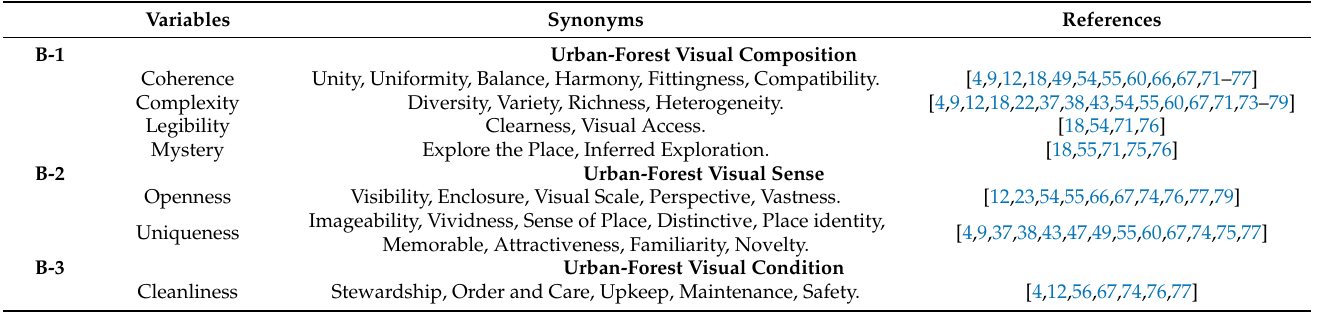
Table 4. Urban-forest visual quality variables were obtained from the systematic